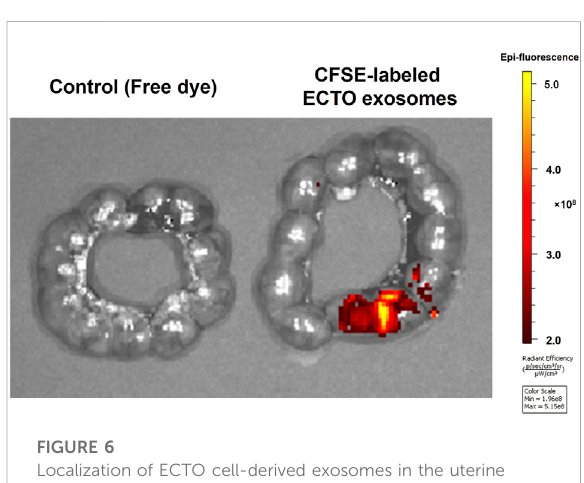
FIGURE 6 Localization of ECTO cell-derived exosomes in the uterine cavity. CFSE-stained ECTO epithelial cell exosomes in the uterine cavity capture via ex-vivo IVIS imaging. Uteri were collected and imaged with IVIS 24 h after vaginal administration of three doses of 4.5 × 10 8 ECTO cell exosomes to E15 pregnant